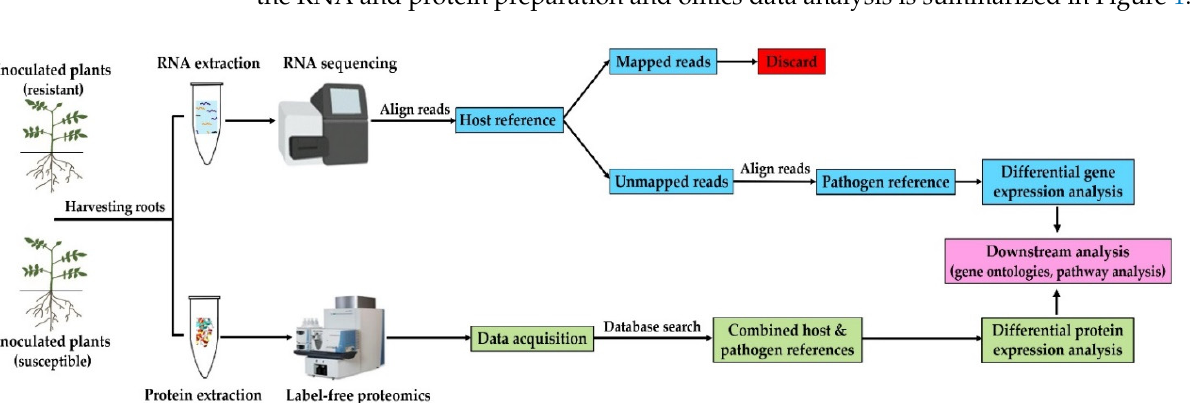
Figure 1. Workflow of analysis. Transcriptome and proteome of S. subterranea were analyzed simultaneously by using different approaches. The mixed transcriptome obtained from S. subterranea -infected potato roots was sequenced by using Illumina mRNA-Seq technology. The reads were aligned to the potato reference genome and unaligned reads were used to analyse the transcriptome of S. subterranea . For the proteome analysis, proteins were extracted from S. subterranea -infected potato roots, analyzed using a label-free approach and searched in a combined host and pathogen database. Further analysis using multiple bioinformatics approaches identified the functional annotation of the differentially expressed genes and proteins.